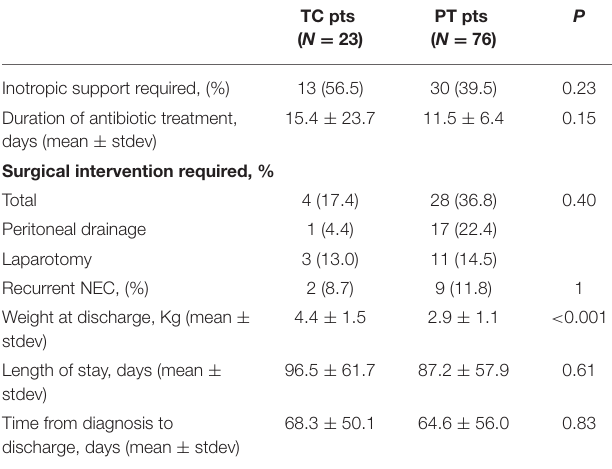
TABLE 3 | Treatment-related outcomes.